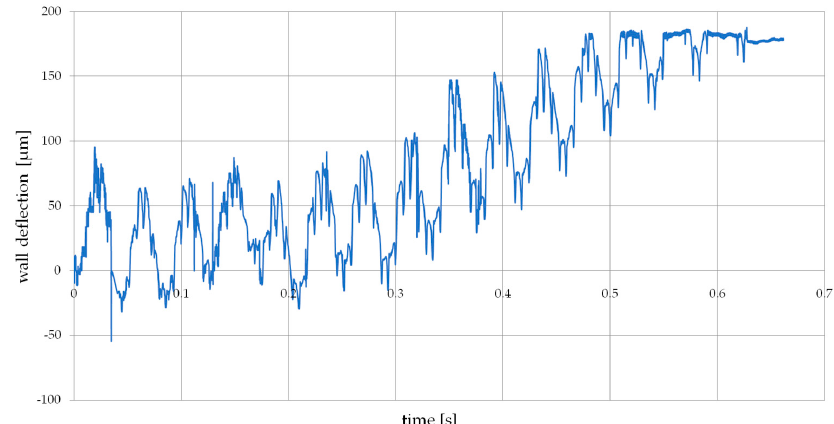
Figure 5. The plot of the deflection of the thin-walled workpiece obtained on the basis of the recording analysis.